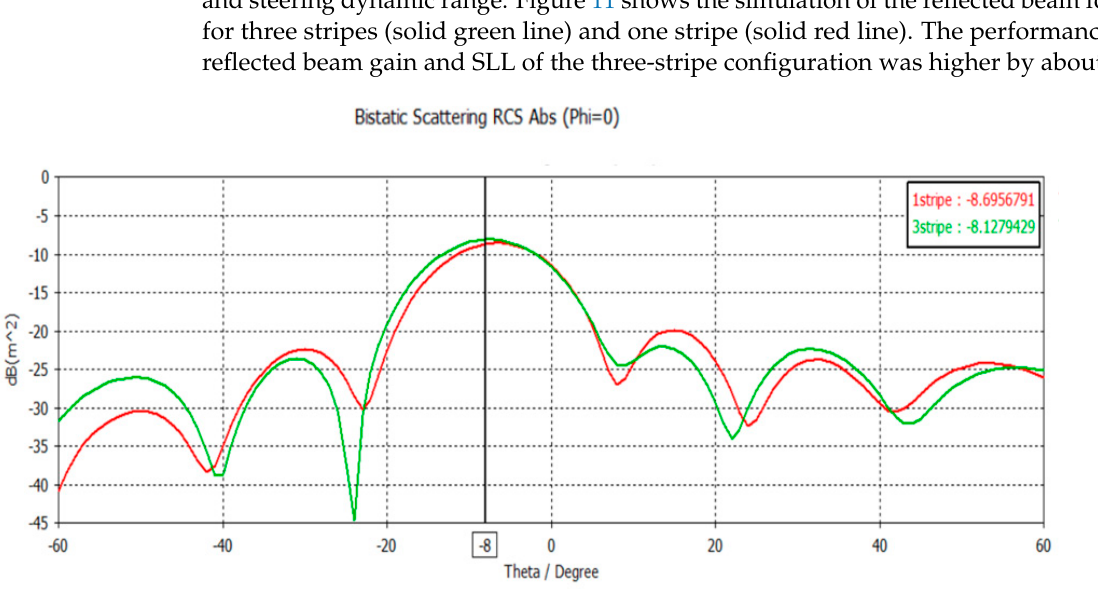
Figure 11. Beam steering far-field radar cross section (RCS) results at 28 GHz in the three-stripe (green) vs. one-stripe configuration (red). Steering angle simulation results of 8° .